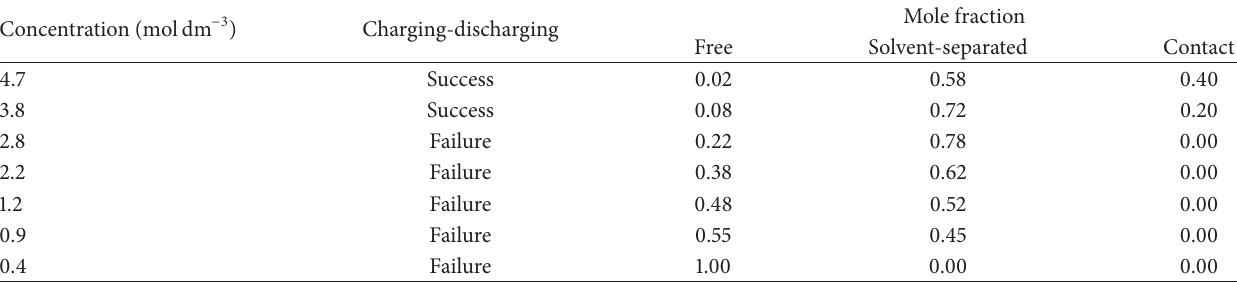
− anions and charge-discharge behaviors of graphite in LiClO 4